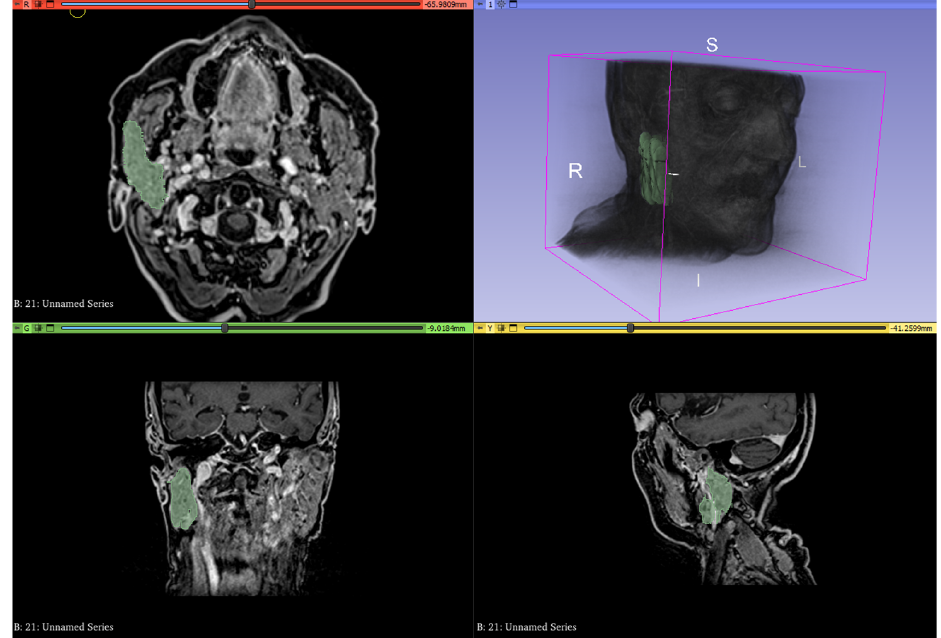
Figure 3. Whole volume segmentation of the right parotid gland using 3D slicer software on contrast ‐ enhanced T1 sequences. The entire process was performed for submandibular and parotid glands of the irradiated side on both pre ‐ and post ‐ RT contrast ‐ enhanced T1 sequences and ADC maps.